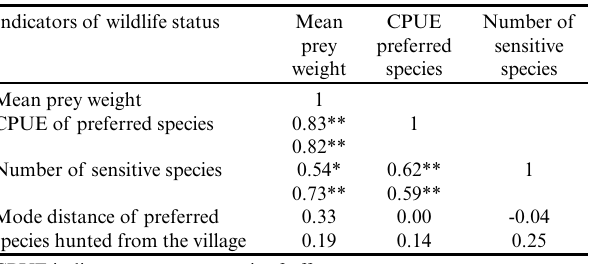
Table 2 . Pearson correlation matrix between simple indicator variables of wildlife depletion in Pano villages (upper) and excluding roadside villages (bottom) in Acre, Brazilian Amazon.